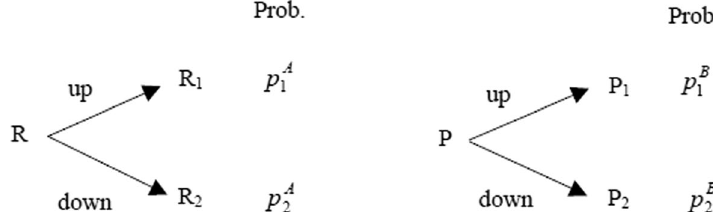
Fig. 10 Individual binomial movements of rent and price